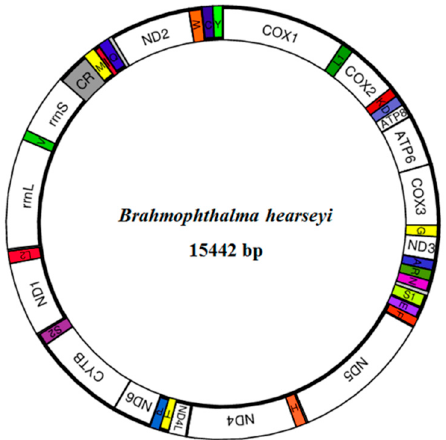
Figure 1. Circular map of the Brahmophthalma hearseyi mitochondrial genome. CR refers to the A + T-rich region.